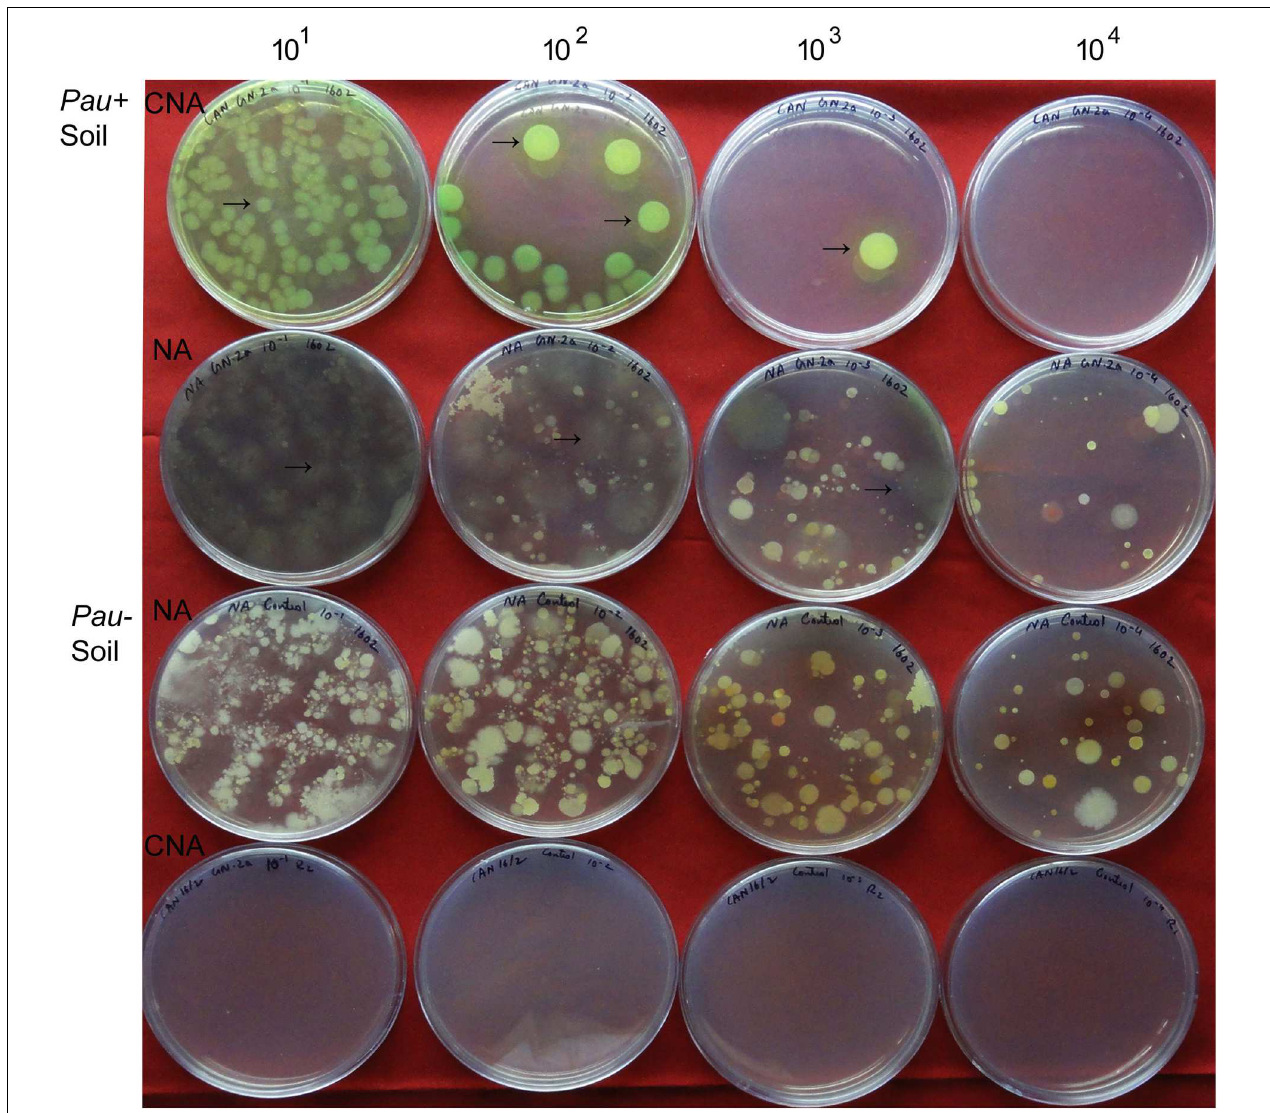
FIGURE 3 | Plating of serial dilutions (10 1 to 10 4 ) of Pau + and Pau − rhizospheric soil mix on CNA and nutrient agar (NA) at the start of the experiment (day-0) and documentation of Pau ( −→ ) and non- Pau cfu as on day-4 after plating (row 1: Pau colonies from Pau + soil on CNA; row 2: Pau cfu on NA appearing brownish and vanishing gradually with evident non- Pau bacterial cfu; row 3: Pau - soil showing non- Pau colonies on NA; row 4: no colony growth on CNA from Pau - soil; Colony counts were taken on days 1, 2, and 4 with the marking of initially formed ones on the reverse of the plate).